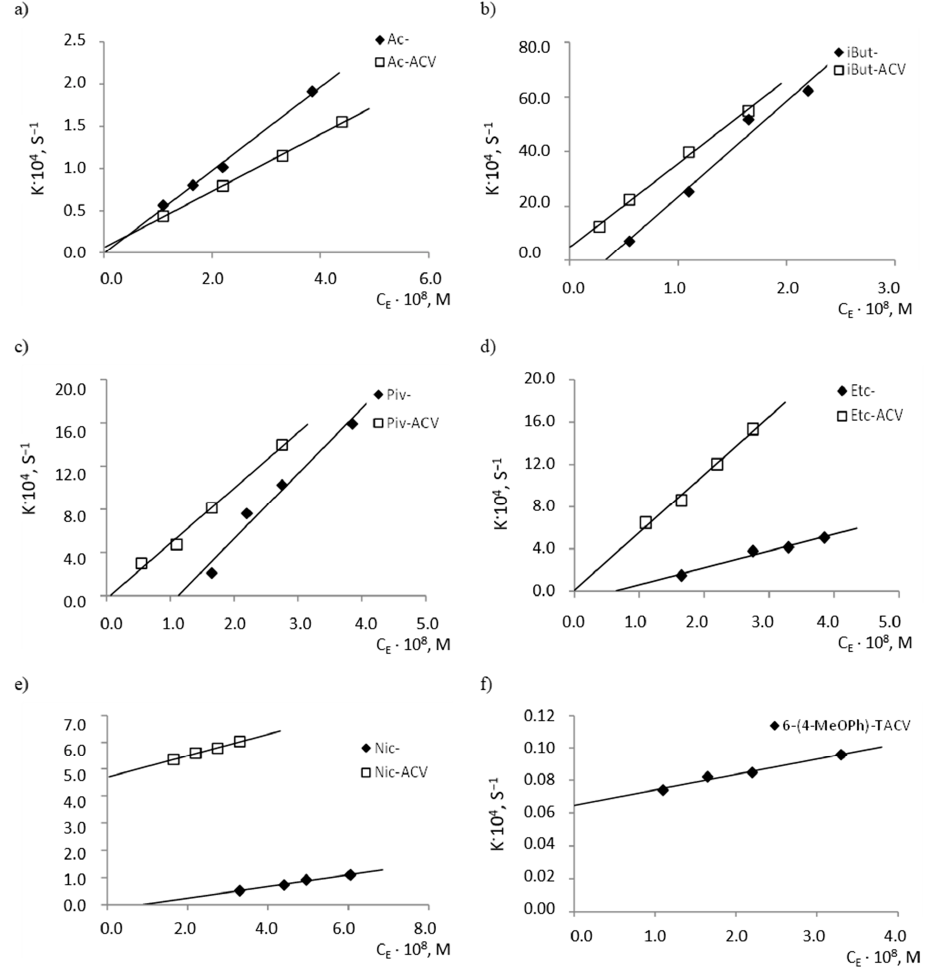
Figure 4. Plots of dependencies k obs. = f ( c E ) of the hydrolysis reaction of ( a ) Ac- and Ac-ACV esters; ( b ) iBut- and iBut-ACV esters; ( c ) Piv and Piv-ACV esters; ( d ) Etc- and Etc-ACV esters; ( e ) Nic- and Nic-ACV esters; ( f ) 6-(4-MeOPh)-TACV compound in plasma (80%, 37 ◦ C) in the presence of porcine esterase at 37 ◦ C.